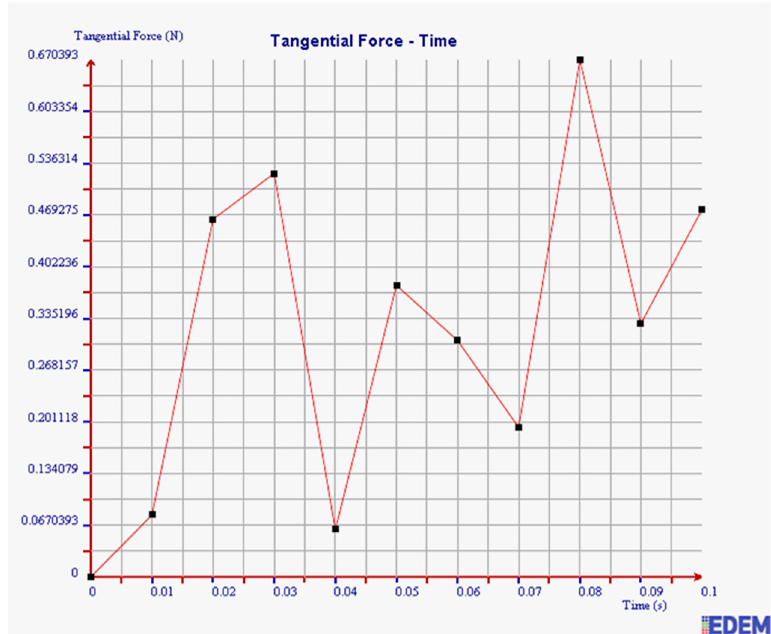
Figure. 16 Tangential force of 2 mm steel balls. Figure 16. Tangential force of 2 mm steel